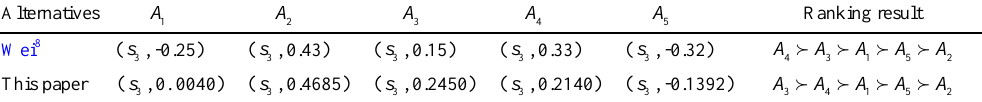
Table 1 The collective overall preference values of alternatives obtained by both